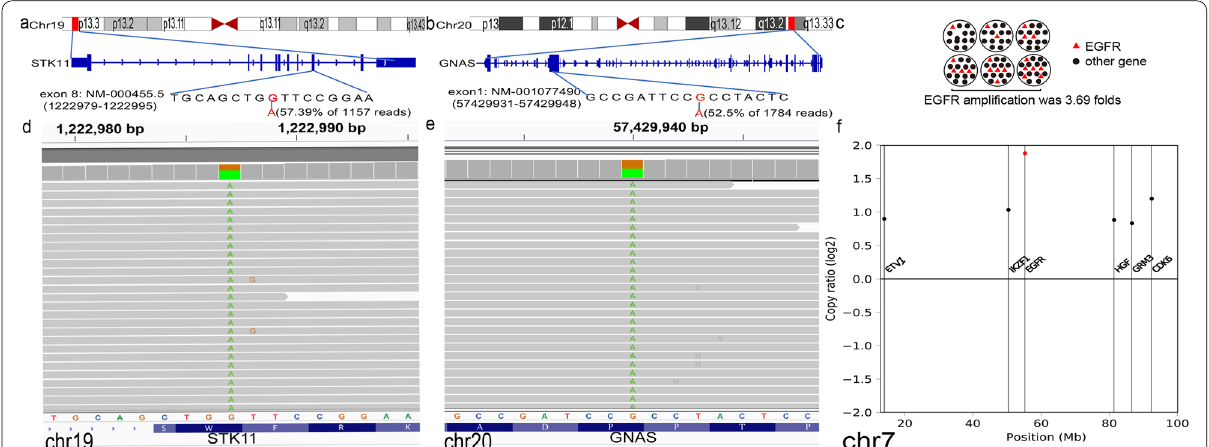
Fig. 3 Molecular profile of the IOPN described in this case. a-c Schematic illustration of STK11 ( a ) mutation, GNAS ( b ) mutation and EGFR ( c ) amplification. d The sequencing result showed STK11 c.924G > A (p.W308*), exon 8 in 57.39% of 1157 reads mutation. e The sequencing result showed GNAS c.1433G > A (p.R478H), exon 1 in 52.5% of 1784 reads mutation. f The sequencing result showed EGFR amplification was 3.69 folds. (Data presented as log2 fold change at the FDR < 0.05)